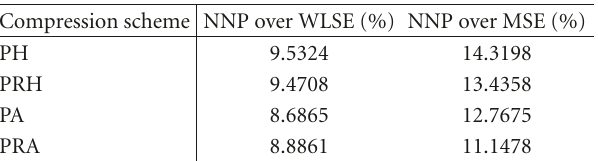
Table 7: Improvement percentage of NNP-based over LP-based compression schemes using average CR